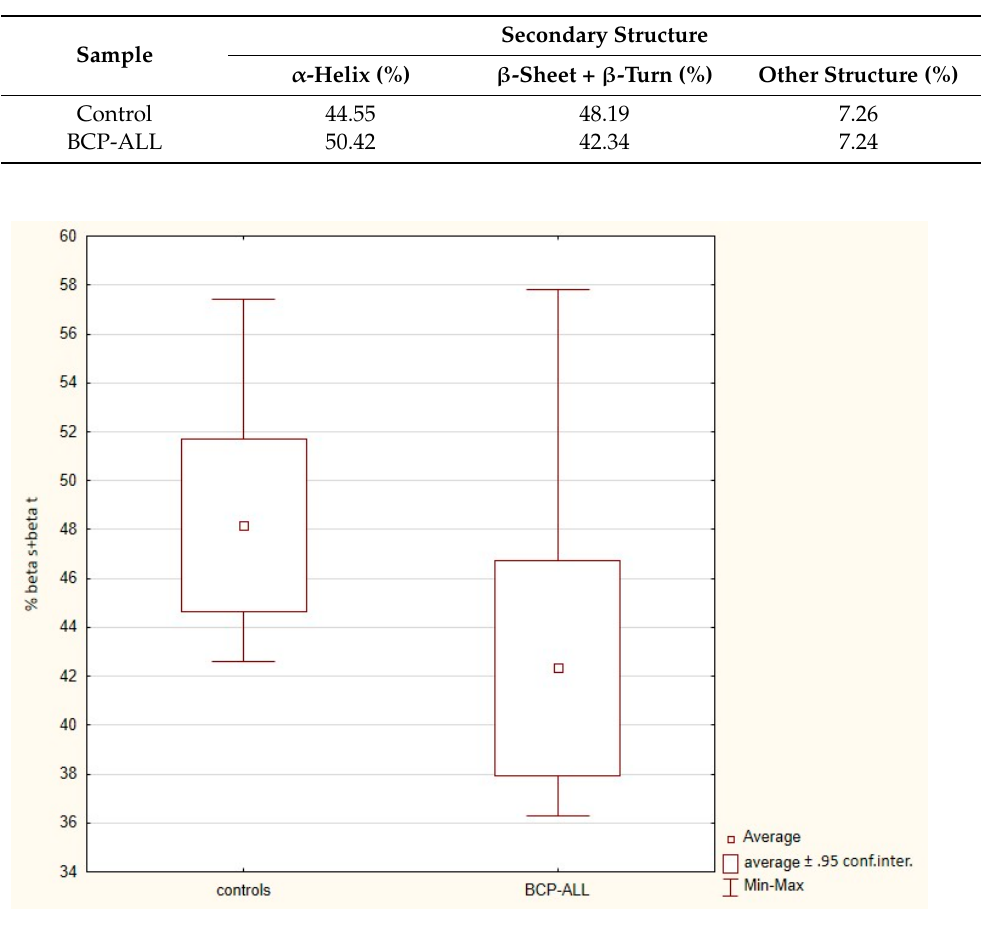
Figure 3. The average percentage of both β -sheet and β -turn (% β s + β t) protein structures in the sera of controls and BCP-ALL patients calculated as the average of the sum of the individual values in each sample ( p = 0.030).